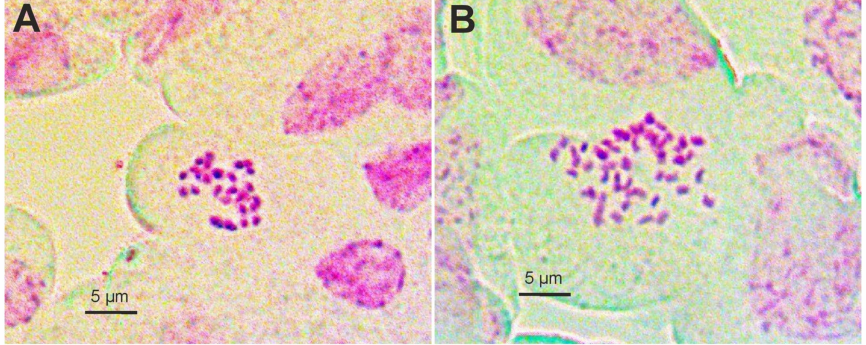
Figure 1. Mitotic chromosomes from Dianthus sylvestris root tips. ( A ) A diploid (2 n = 2 x = 30) from the population D185 (Punat, Krk island, Croatia) and ( B ) a tetraploid (2 n = 4 x = 60) from the population D12 (Plomin, Mt Uˇcka,